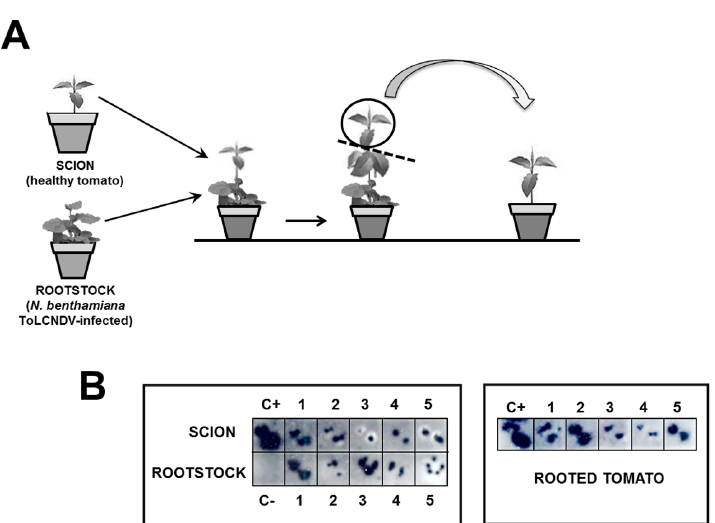
Figure 1. Graft assay. ( A ) Schematic representation of graft assay of healthy tomato cultivar Moneymaker scions on Nicotiana benthamiana rootstocks infected with the tomato leaf curl New Delhi virus (ToLCNDV) isolate from Spain (ToLCNDV ‐ [ES ‐ Alm ‐ 661 ‐ Sq ‐ 13]) followed by rooting detached apical tissues of infected tomato plants; ( B ) molecular hybridization of squash blots of cross ‐ sections of petioles of young leaves of tomato scions performed on positively ‐ charged nylon membranes at 90 days post grafting and at 30 days post rooting of apical tissues.